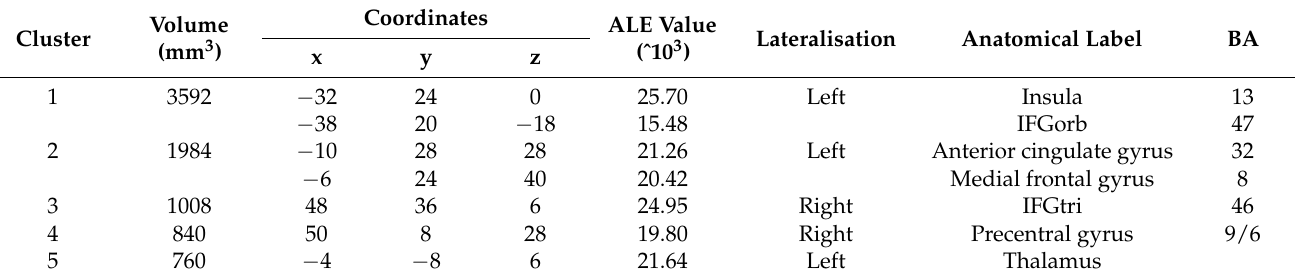
Table 3. Results of the meta-analysis on shame/embarrassment processing.